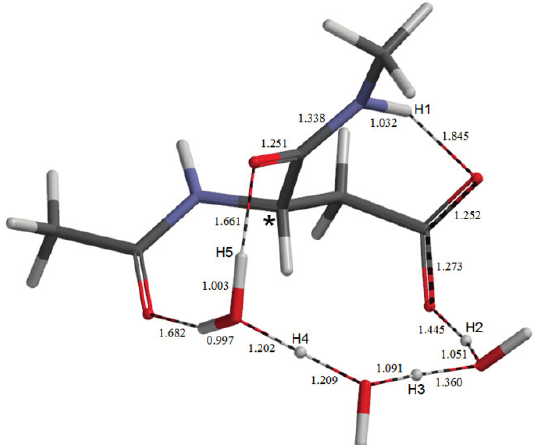
Figure 3. The geometry of the first-step transition state TS1 . Selected interatomic distances are shown in Å.